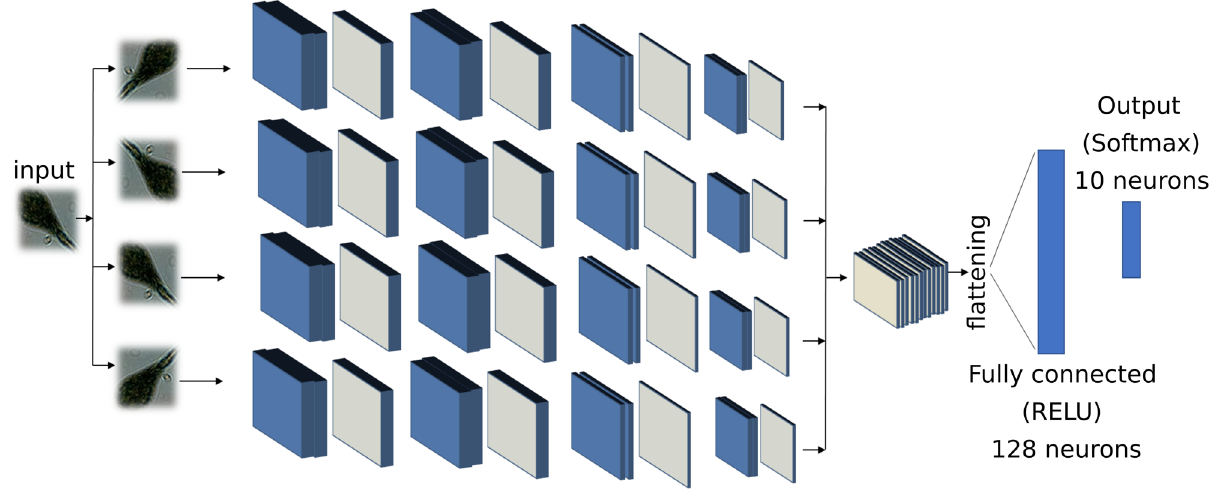
Figure 6. Deep features extraction. Deep CNN implemented for the purpose of deep features extraction. The blue layers represent convolutional layers, the grey ones represent a max pooling 2D operation. The fully connected layer with 128 neurons output has been used as feature set to the subsequent modules in our